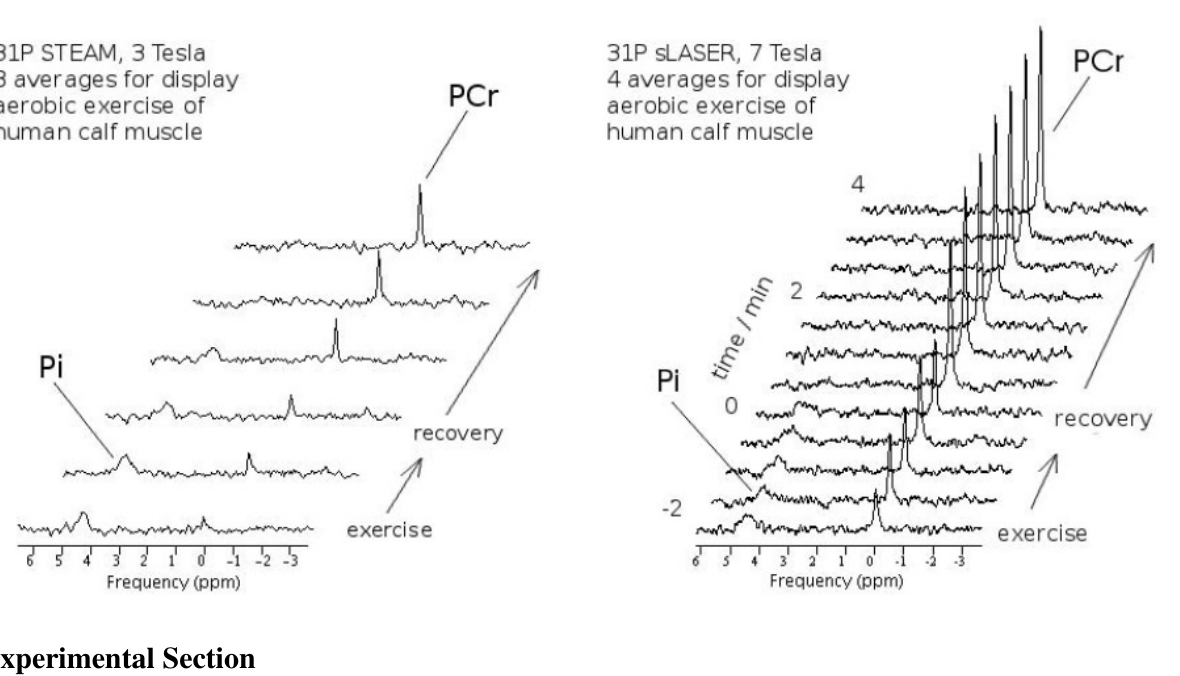
Figure 11. Dynamic localized 31 P MRS of skeletal muscle acquired at 3 Tesla (left) and 7 Tesla (right). Signal gain at 7 T (in connection with an improved acquisition method, 31 P semi-LASER) allows higher time resolution and yet surpasses spectral quality for quantification of creatine phosphate (PCr) and inorganic phosphate [87] time courses during and after aerobic exercise of human muscle, compared to a similar measurement at 3 T. Spectra were scaled to equal noise